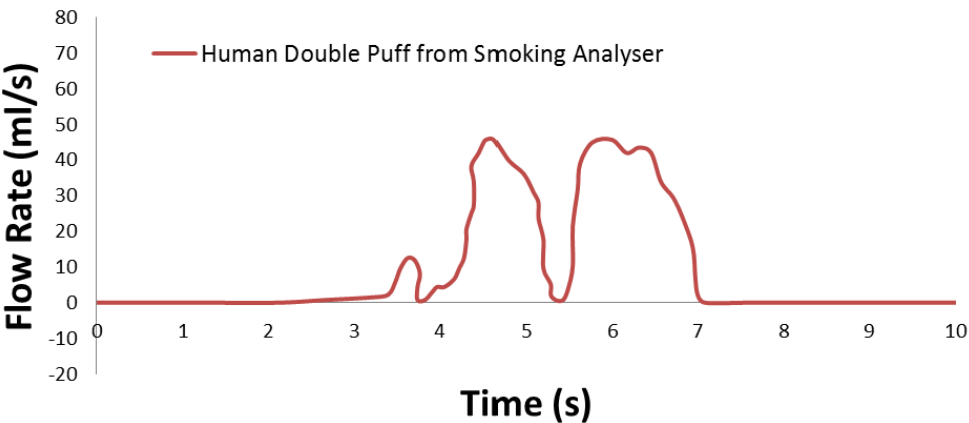
Figure 4. Human double-puff profile (adapted from